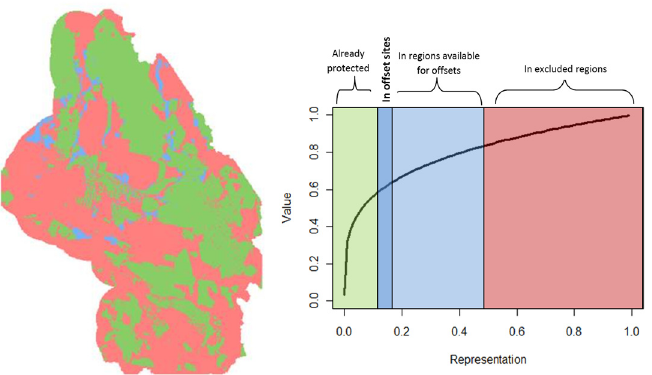
Fig 2. Map illustrating the use of a utility curve in Zonation. The colors on both map and chart correspond to regions of protected lands (green), area available for offsets (blue), selected offset sites (darker blue), and areas excluded for offset site consideration (red). Map is for illustrative purposes and does not accurately reflect current availability